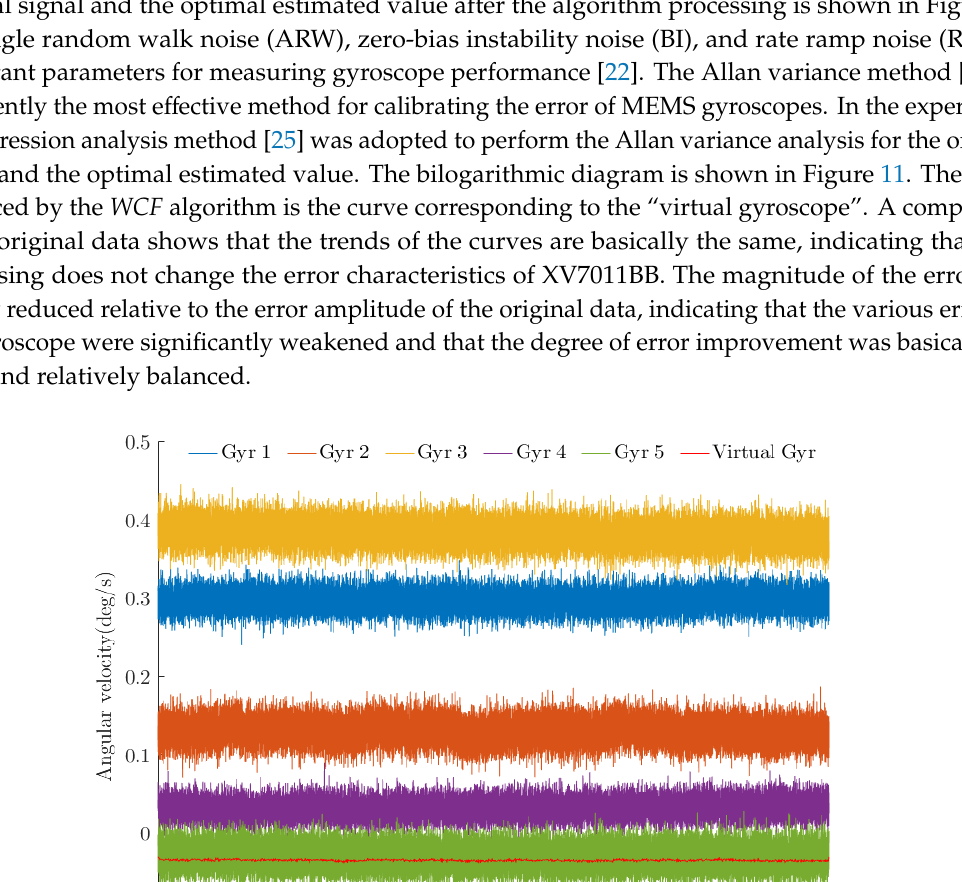
Figure 10. Processing results (only five groups of the original data are visualized).